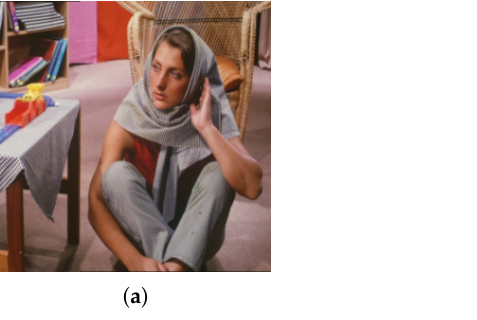
Figure 21. Standard images. ( a ) Barbara. ( b ) Parrots. Table 7. Experimental parameters for different input images.